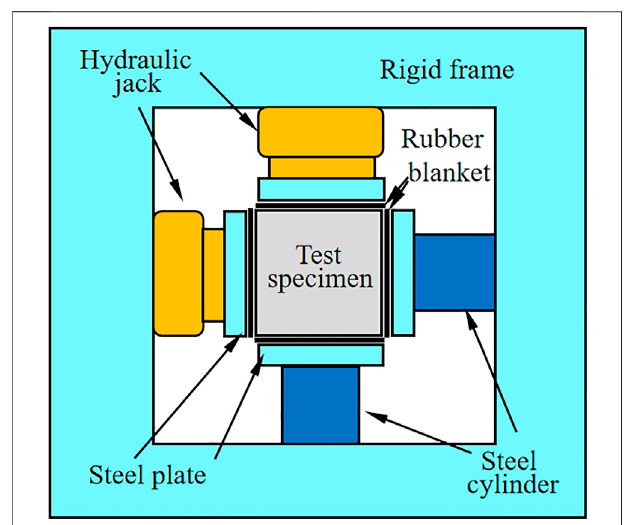
FIGURE 4 | Platform loading form and